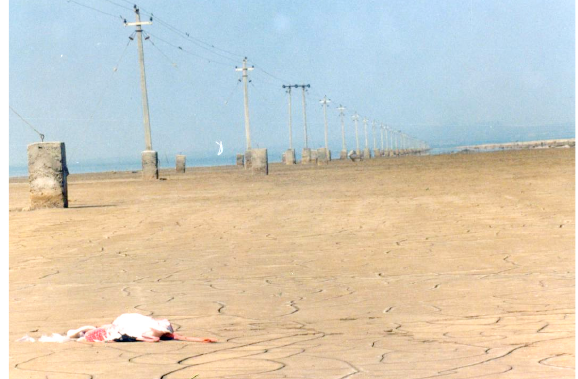
Image 1. Collision of Lesser Flamingo with distribution line at Shiranivandh